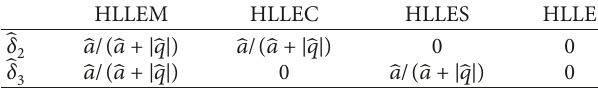
Table 1: Definition of four HLL type